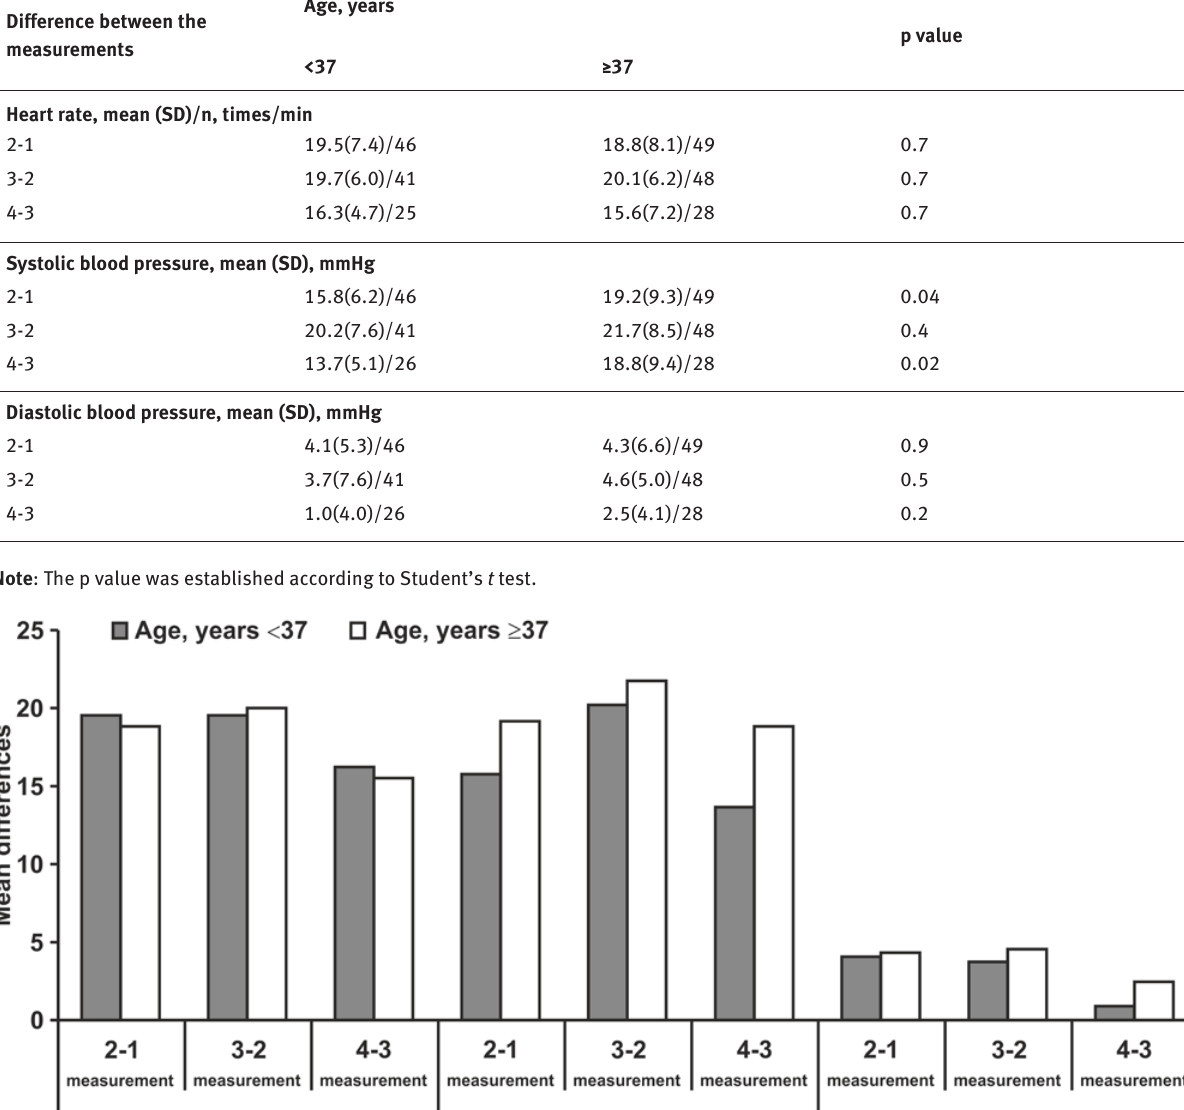
Difference between the